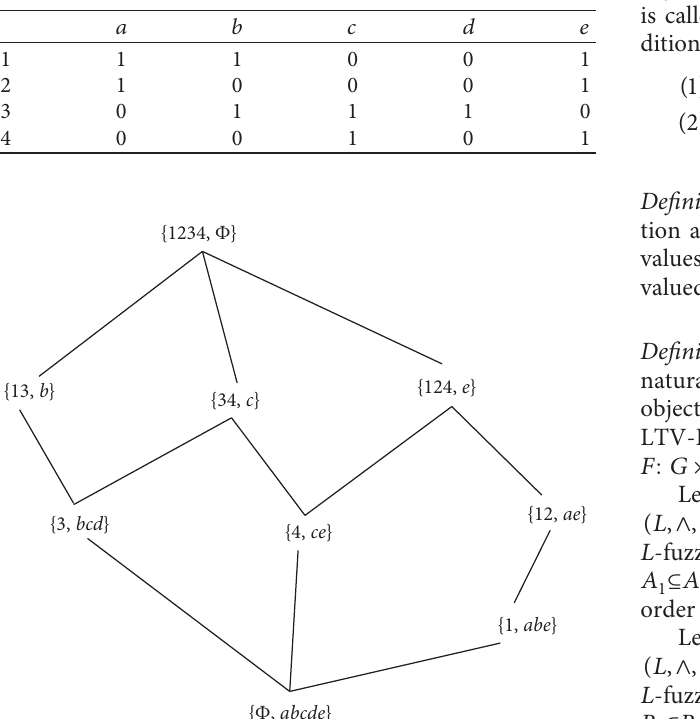
Table 1: Formal context ( A, B, I )